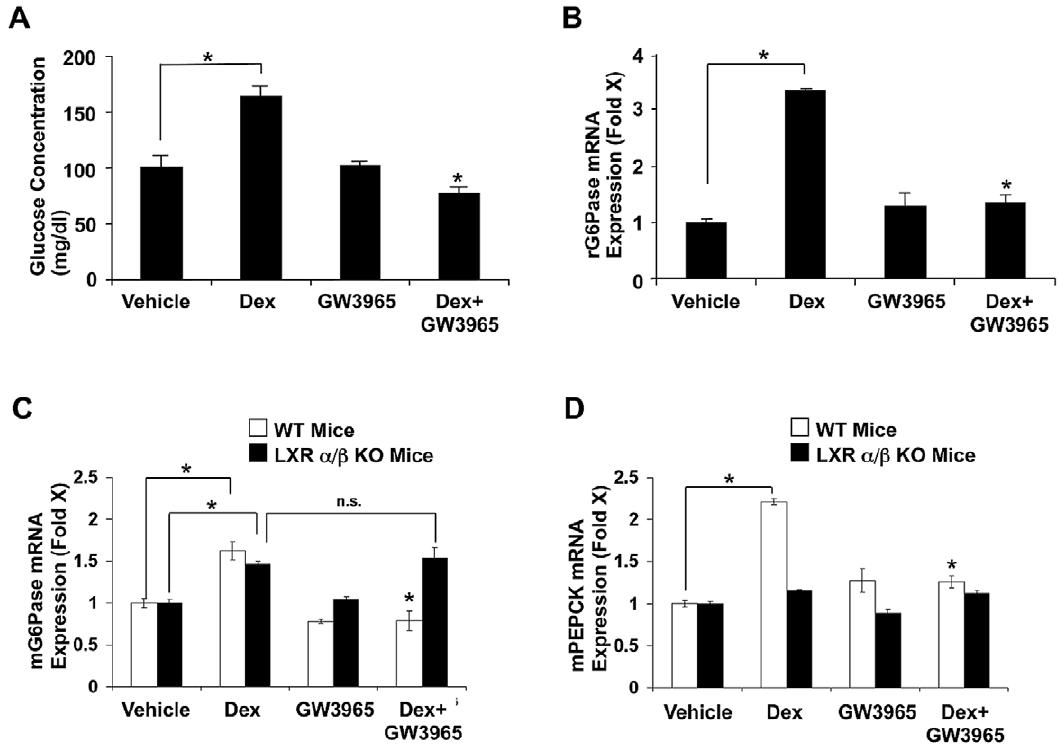
Figure 4. GW3965 attenuates dexamethasone-induced hyperglycemia in rats and represses dexamethasone-induced G6Pase mRNA expression in mouse and rat livers and PEPCK mRNA expression in mouse livers. A. GW3965 attenuates dexamethasone-induced increase of blood glucose levels in rats. Blood glucose levels were measured in rats treated with the compounds indicated. Bars represent mean 6 S.E. values of the blood glucose concentration. *: p , 0.01, compared to the animals treated with dexamethasone or between the two conditions indicated. Dex: dexamethasone. B, C and D. GW3965 suppresses dexamethasone-induced mRNA expression of glucocorticoid-responsive G6Pase in the livers of rats (B), G6Pase and PEPCK in wild type, but not LXR a / b knockout mice (C and D). Rats, wild type (WT) and LXR a / b knockout mice were orally gavaged for three days with GW3965, and were injected with dexamethasone or physiologic saline intramuscularly. Twenty-four hours after the injection, Total RNA was harvested from their livers and mRNA levels of rat G6Pase (B), mouse G6Pase (C) and mouse PEPCK (D) were measured with the SYBR-Green real-time PCR. Bars represent mean 6 S.E. values of the fold induction of mRNA expression against vehicle. *: p , 0.01, n.s.: not significant, compared to the animals treated with dexamethasone or between the two conditions indicated. Dex: dexamethasone, KO: